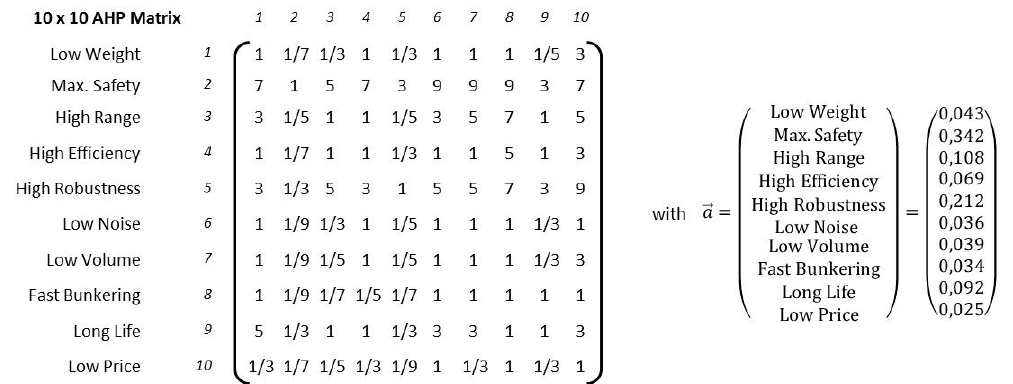
Fig. 3. The AHP Matrix with the associated pairwise